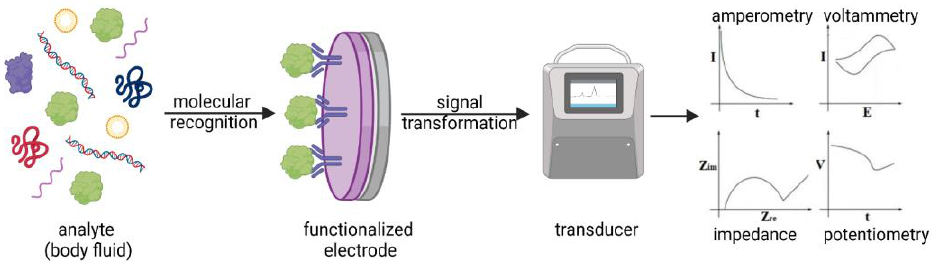
Scheme 2. Schematic diagram showing the working principle of an electrochemical biosensor. Cre- ated with